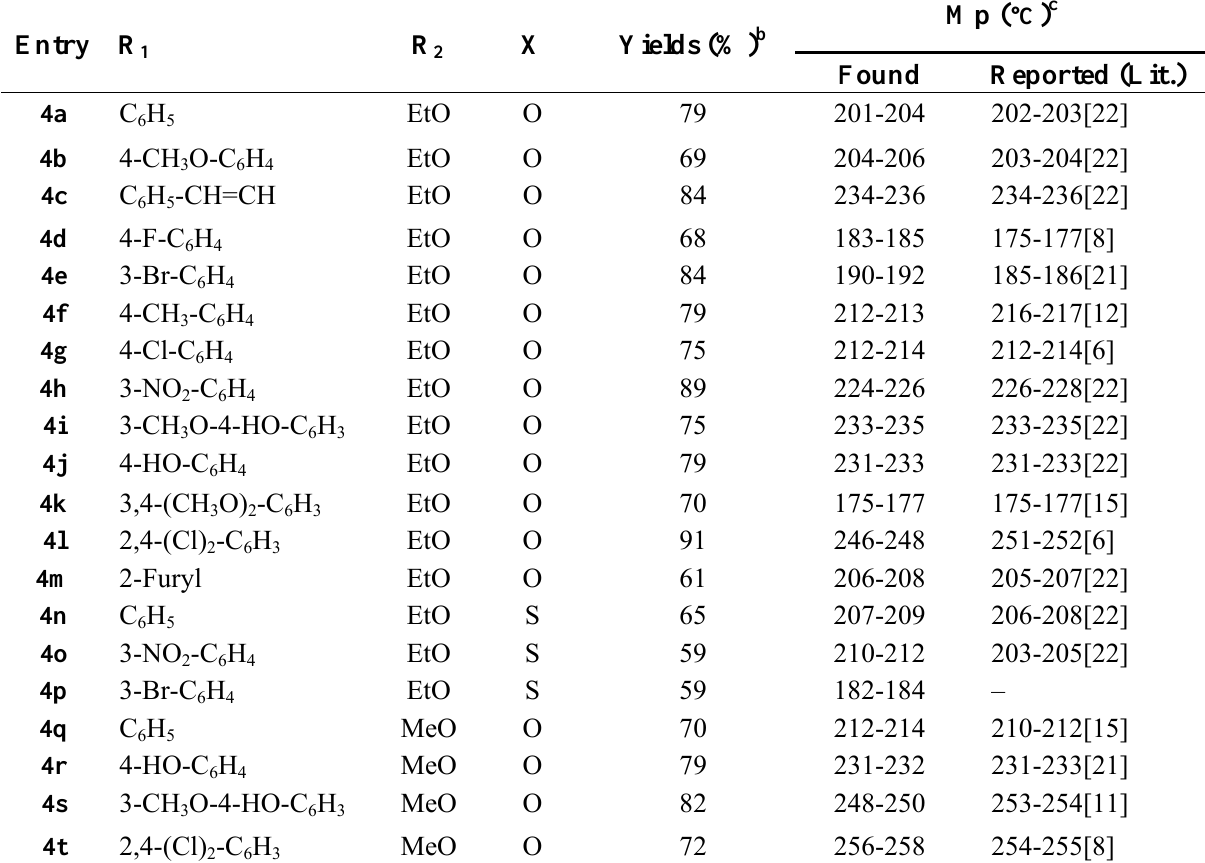
SO ) -catalyzed one-pot synthesis of 3,4-dihydropyrimidin-2(1 H )-ones/thiones 2 3 2